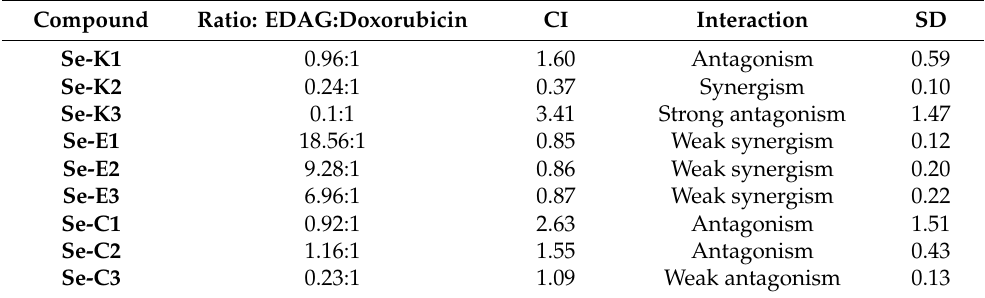
Table 1. Interaction of symmetrical selenoesters with doxorubicin on Colo 320 cells. Compound